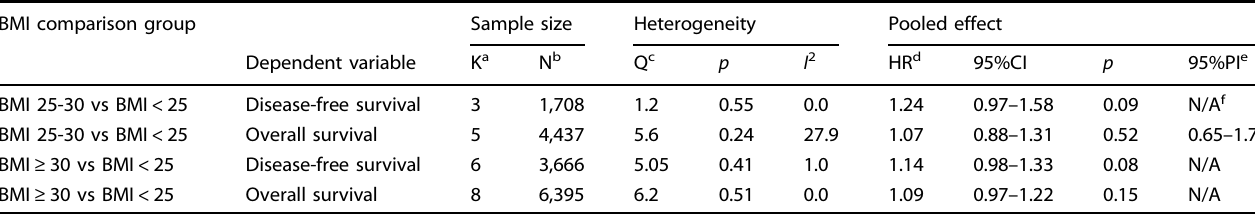
Table 3. Pooled effects of body mass index subgroups on disease-free survival and overall survival.